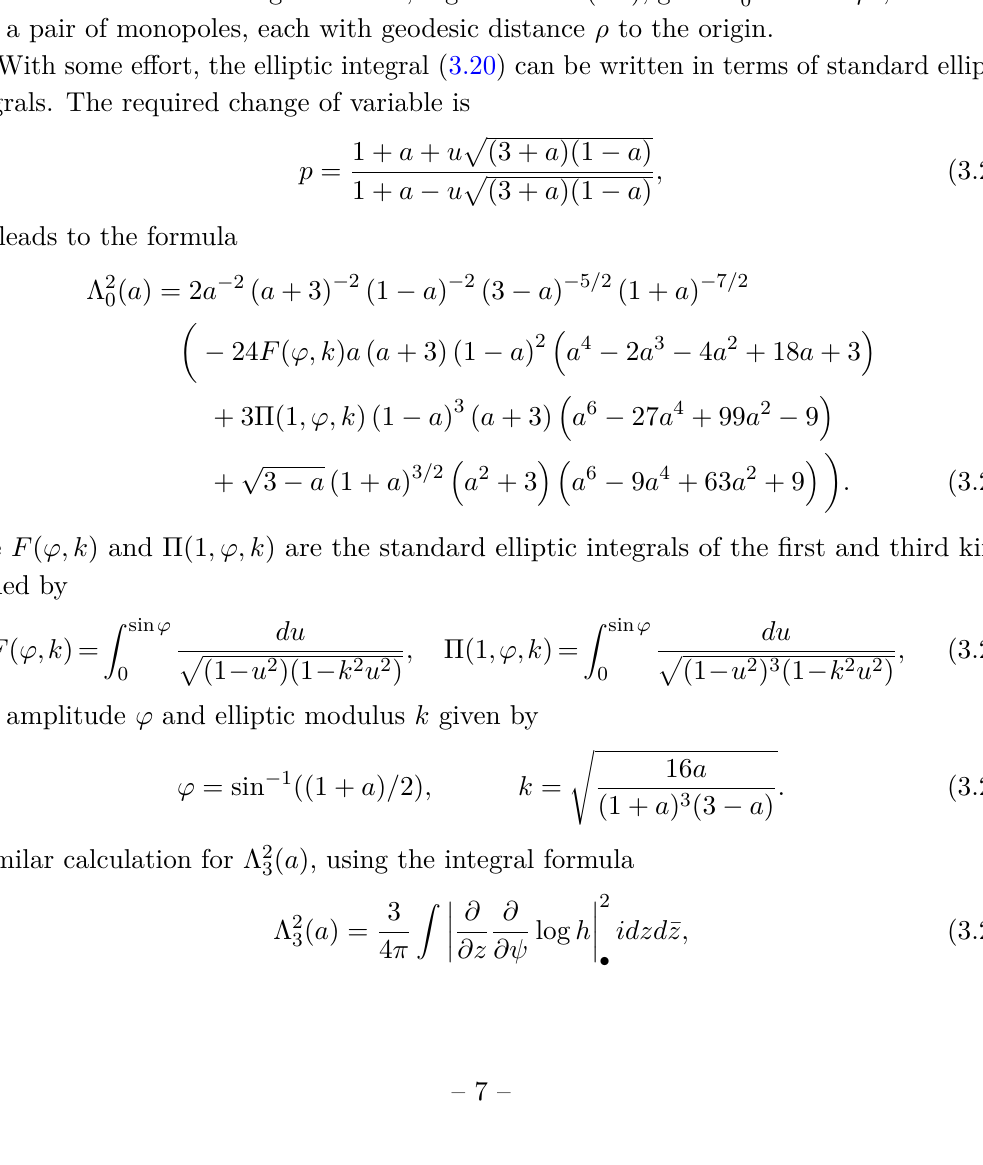
so that for a ∼ 1 the limiting behaviour, together with (3.3), gives Λ 2 with a pair of monopoles, each with geodesic distance ρ to the